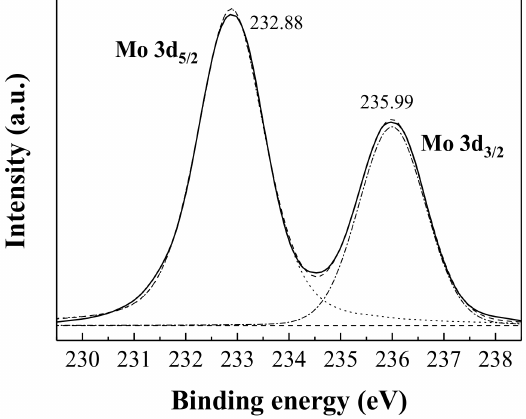
Figure 6. High resolution scan of Mo 3d doublet core levels of α -MoO 3